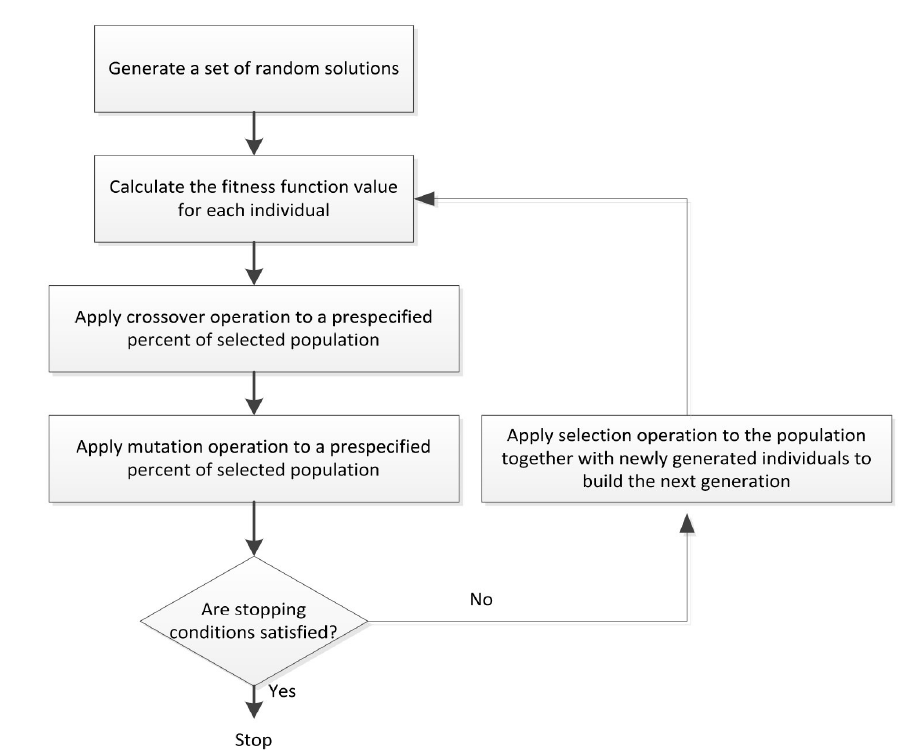
Figure 1. Flowchart of genetic